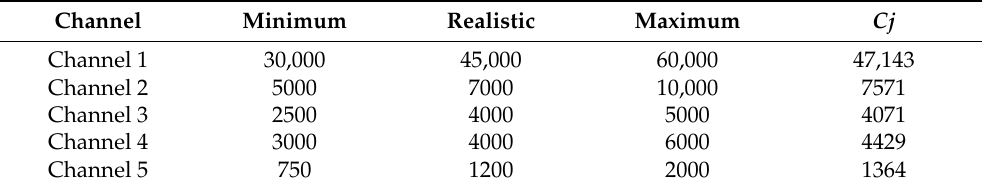
Table 2. Results of expert forecasting in